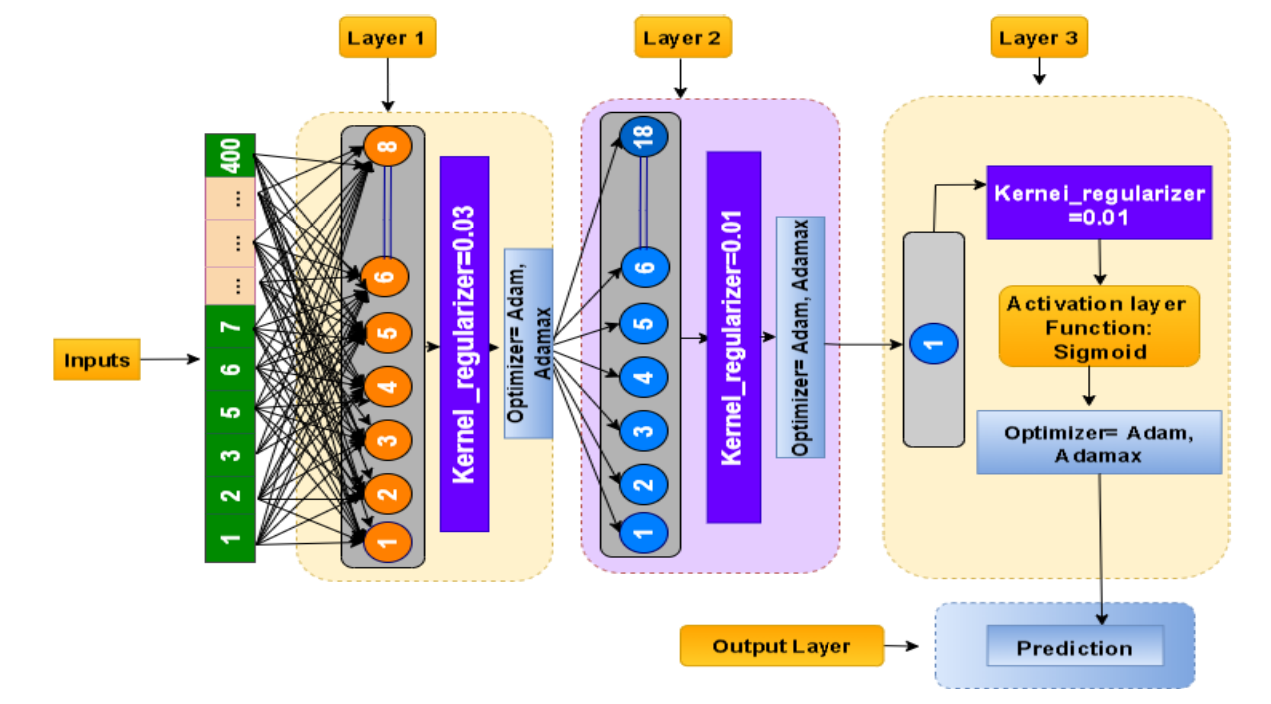
Figure 4. The architecture of optimized artificial neural network (OANN), a fine-tuned network.